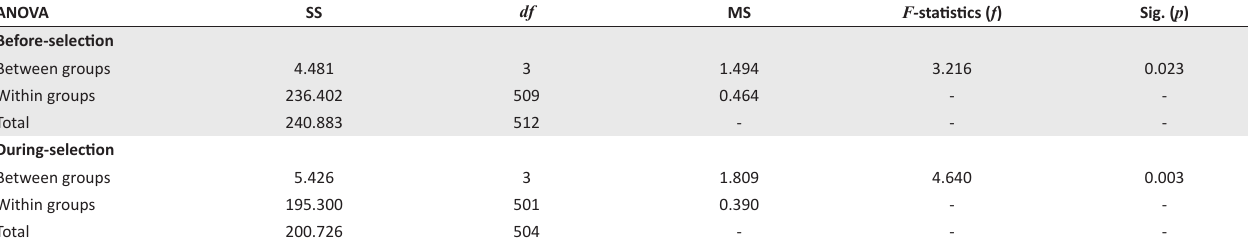
TABLE 4: Analysis of variance comparison between engineering field groups. ANOVA SS df